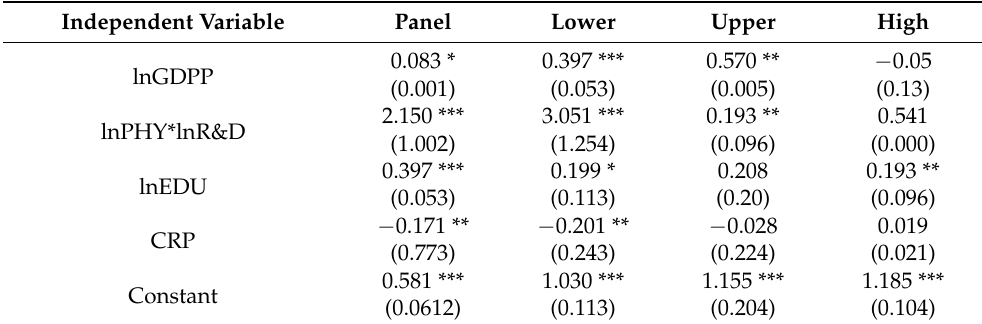
Table 8. Model 2: Simar and Wilson